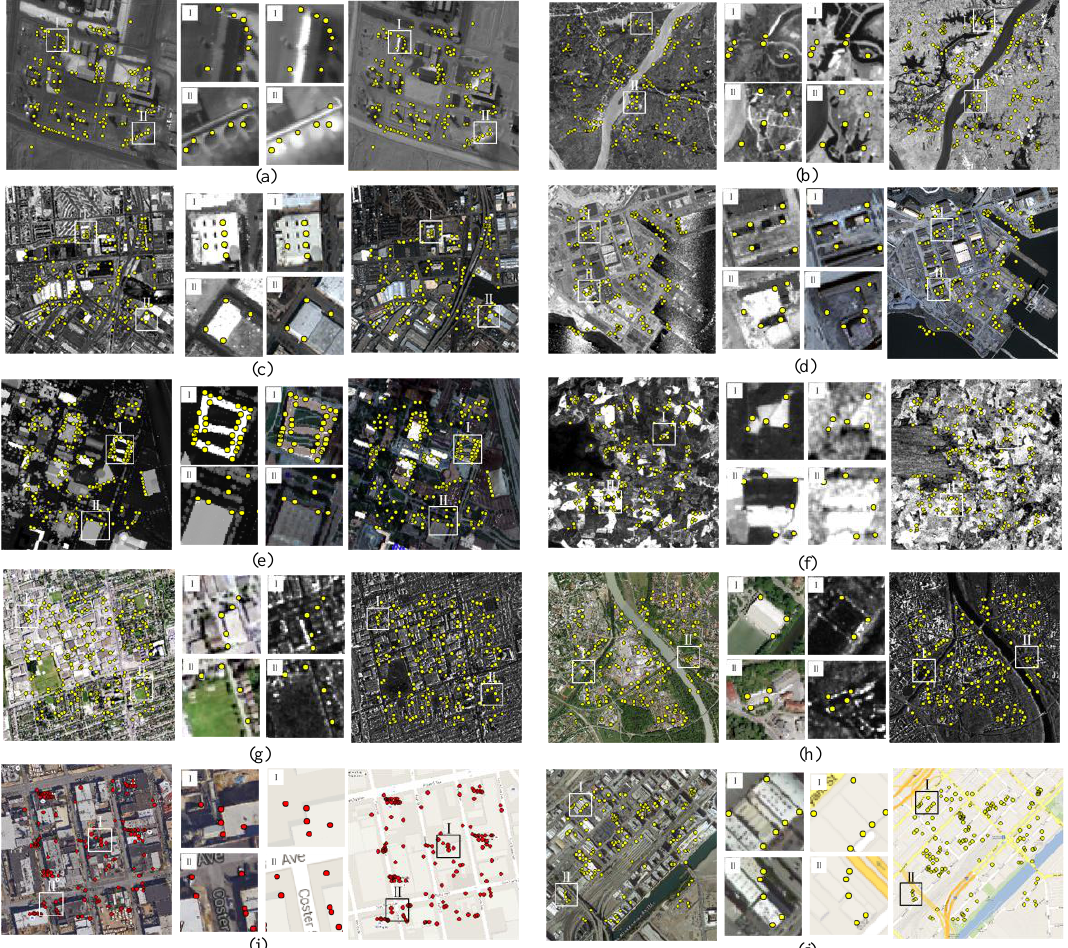
Figure 12. The correct matching points of all the tests by HOPC in the template sizes of 100 × 100 pixels. (a) test 1. (b) test 2. (c) test 3. (d) test 4. (e) test 5. (f) test 6. (g) test 7. (h) test 8. (i) test 9. (j) test 10. × 100 pixels (Figure 12). In short, MI is most time-consuming, followed by HOPC, NCC and MTM